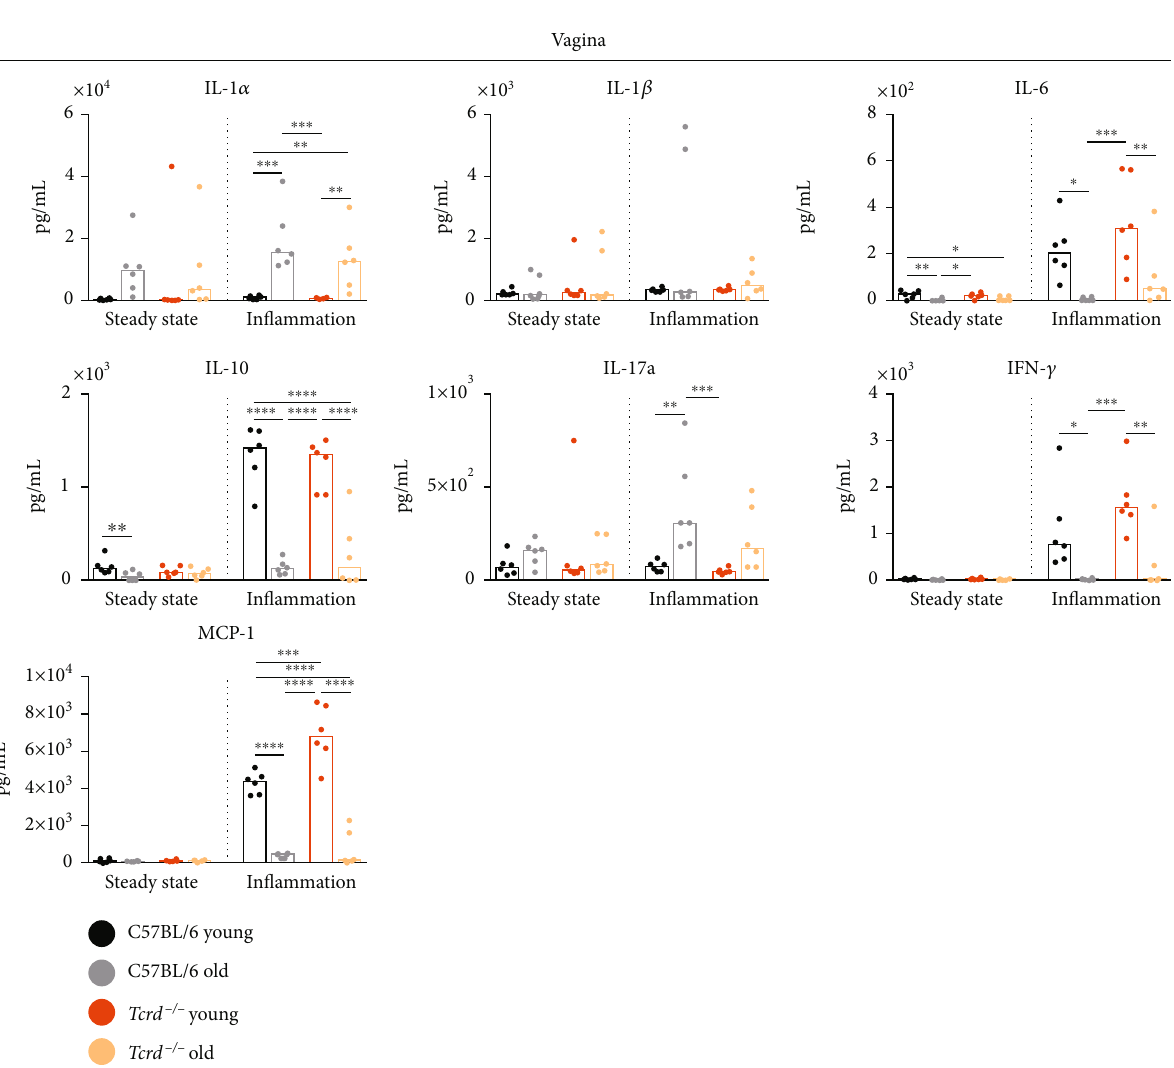
Figure 3: The vaginal cytokine pro fi le at the steady state and upon in fl ammation. Concentrations of cytokines in the vaginal wall in WT and Tcrd -/- mice. Each spot represents an individual mouse; n = 6 mice per group; bars show medians; ∗ p < 0 : 05 ; ∗∗ p < 0 : 01 ; ∗∗∗ p < 0 : 001 ; ∗∗∗∗ p < 0 : 0001 , ANOVA